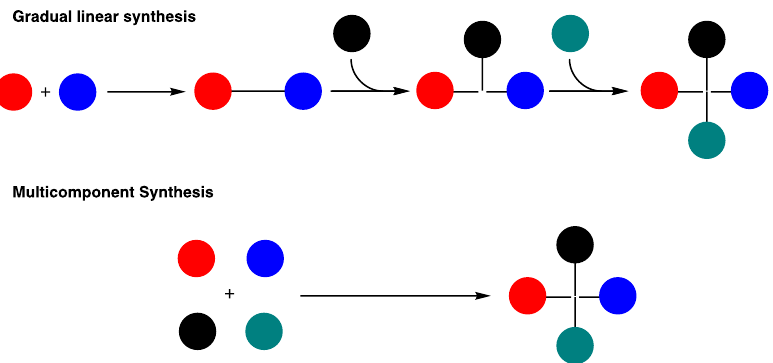
Figure 1. Traditional linear synthesis (3 steps) vs. multicomponent assembly (1 step).